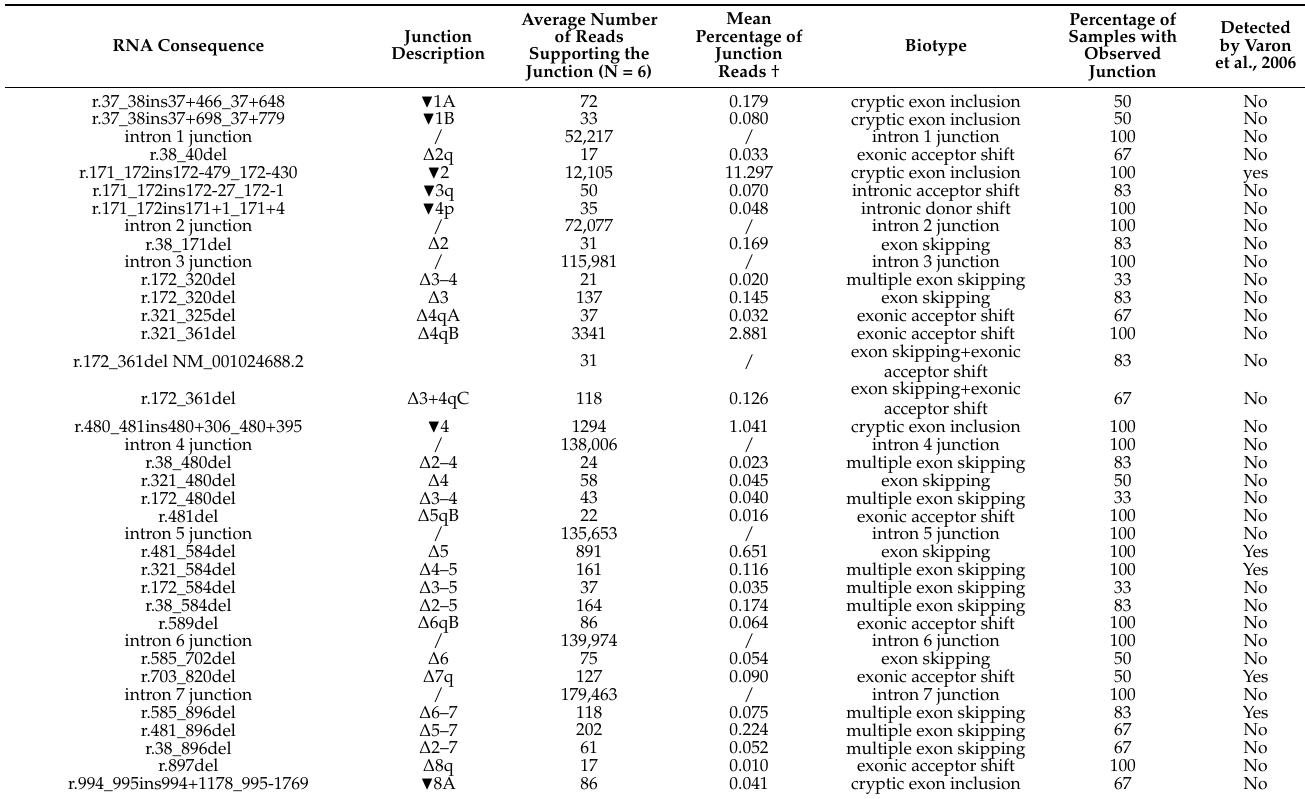
Table 2. Splicing events of NBN (NBS1) gene detected by new RNAseq approach from control samples. RNA